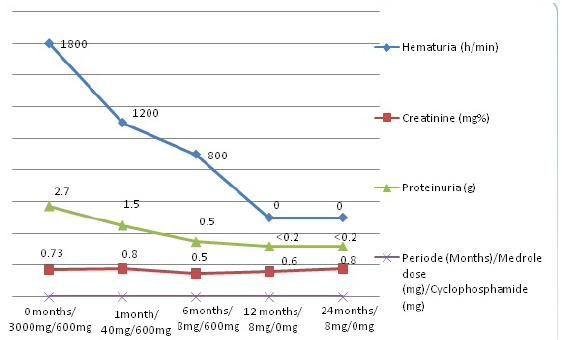
Figure 2. One-year follow-up of biological parameters (hematuria, creatinine,